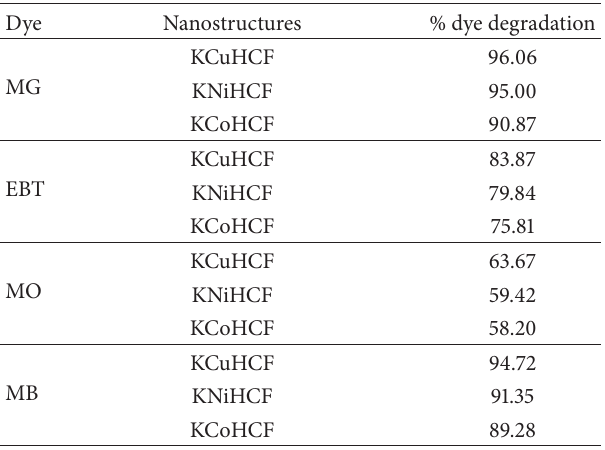
Table 2: Degradation of different dyes using different KMHCF